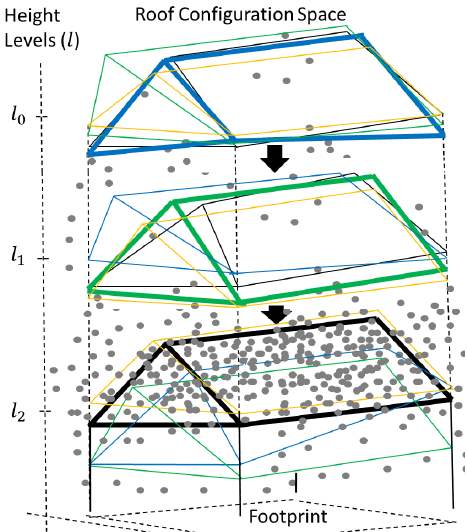
Figure 1: At each height level, the configuration with the high- est likelihood is marked in bold. The black arrows describe the transition of the configurations from one level to the next and the gray dots are data points. Different colors correspond to different configurations. Please note that the space between height levels is widely exaggerated for a better comprehension.